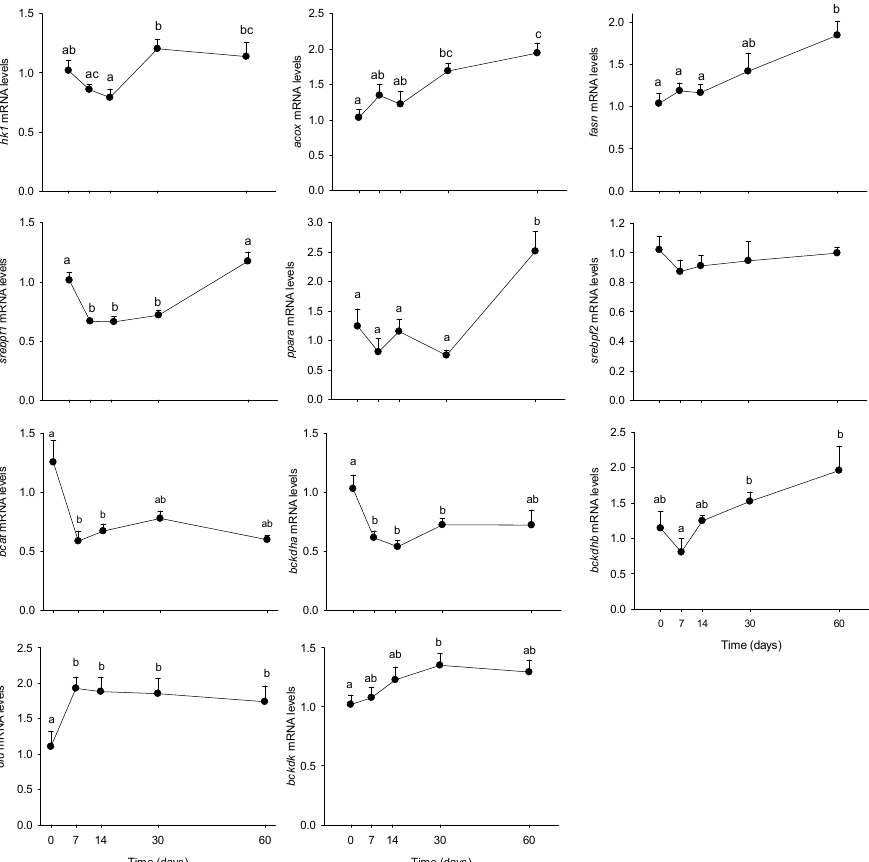
Figure 5. Hexokinase ( hk1 ), acyl-coenzyme A oxidase ( acox ), fatty acid synthase ( fasn ), sterol regulatory element binding protein-1c ( srebf1c ), peroxisome proliferator-activated receptor alpha ( ppara ), sterol regulatory element binding protein-2 ( srebf2 ), branched-chain alpha-keto acid dehydrogenase alpha/beta ( bckdha/b ), dihydrolipoyl dehydrogenase ( dld ), and branched chain ketoacid dehydrogenase kinase ( bckdk ) mRNA levels in PBMCs from Yucatan mini-pigs fed on high fat-high sucrose (HFHS) diet for 2 months. Samples were obtained after an overnight fast period before (0) and 7, 14, 30, and 60 days after HFHS feeding. Results are expressed as means + SEM ( n = 5) and were analysed using a one-way ANOVA test followed by post-hoc Holm-Sidak. Different letters indicate significant differences between the sampling points ( p <